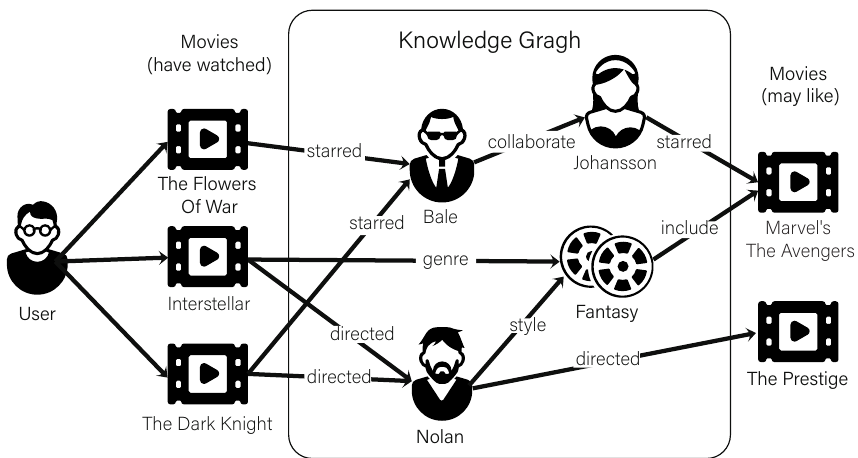
Figure 1. High-order link of entities in the movie knowledge